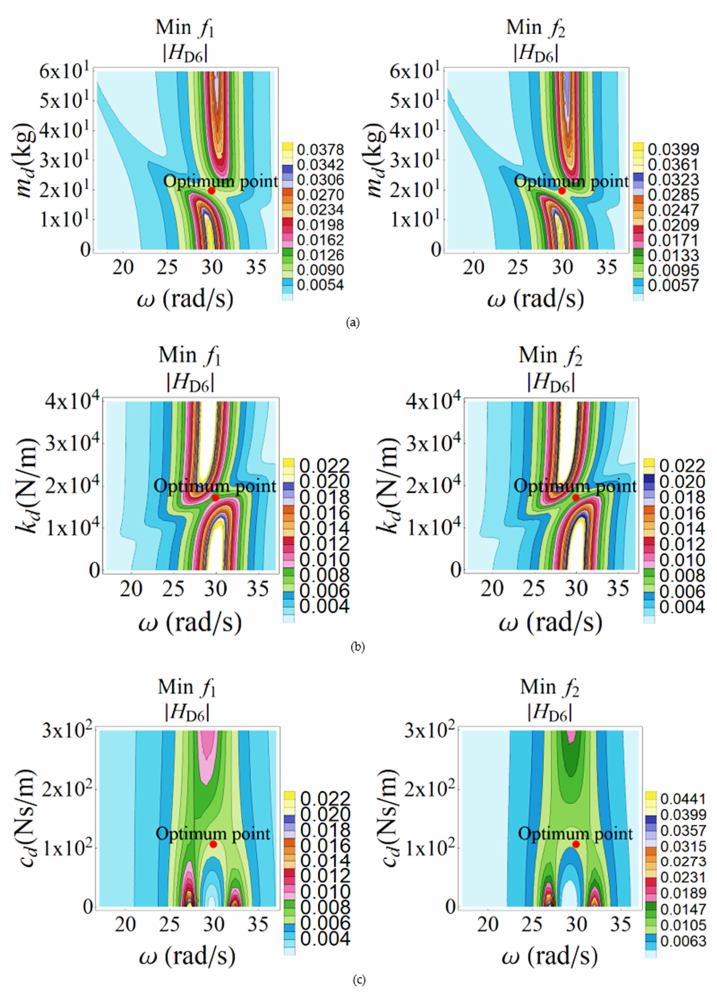
Figure 16. Contour plot of the 6th node vertical absolute displacement transfer function | H D 6 ( ω ) | , with respect to frequency and ( a ) TMD mass coefficient, ( b ) TMD stiffness coefficient, and ( c ) TMD damping coefficient, considering f 1 and f 2 minimization for the first mode